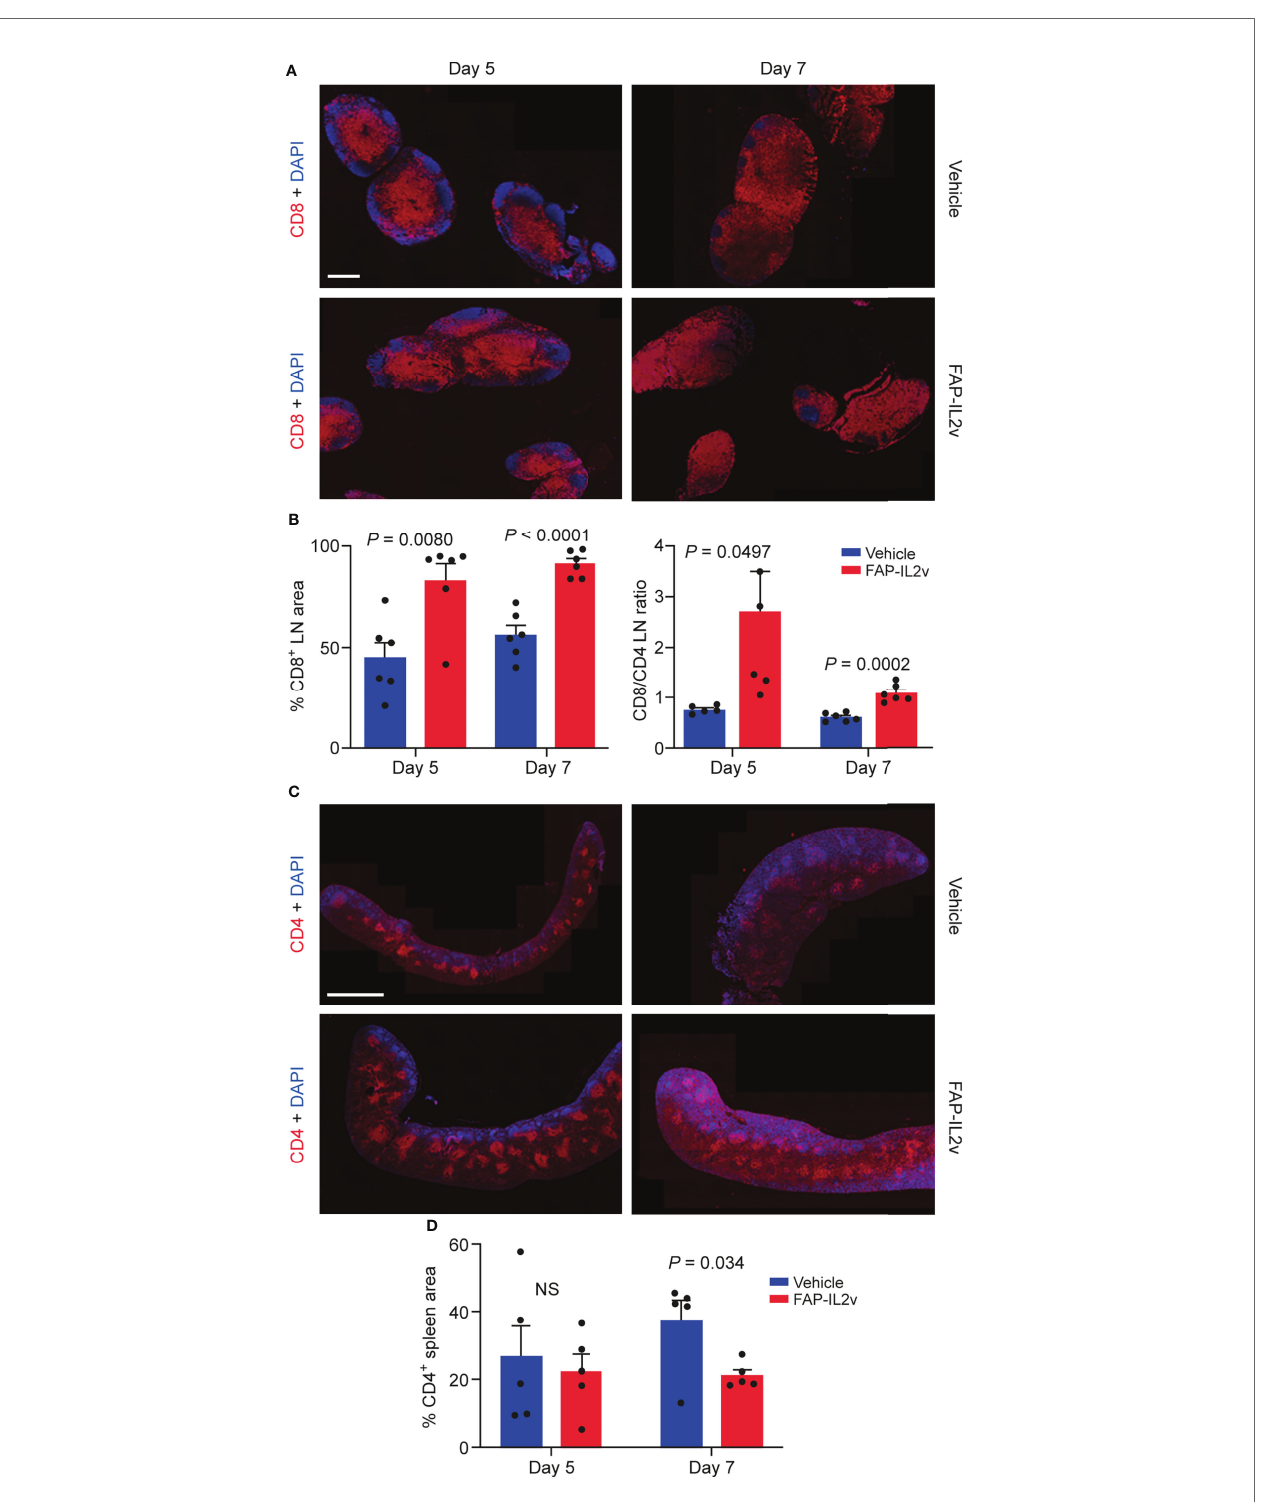
FIGURE 5 | Treatment of mice with an IL-2 variant fused to fi broblast activation protein (FAP-IL2v) induces alterations in immune cell populations. (A) Representative immuno fl uorescence staining of CD8 + T cells in lymph node (LN) sections from vehicle-treated and FAP-IL2v-treated mice. The scale bar is 800 µm. (B) The area of the LN stained positive for CD8 + T cells (as assessed by quantitative analysis of immuno fl uorescence staining) and the CD8 + /CD4 + ratio in the LN ( n = 5-6/group). (C) Representative immuno fl uorescence staining of CD4 + T cells in spleen sections from FAP-IL2v-treated and vehicle-treated mice. The scale bar is 2 mm. (D) Quantitative analysis of immuno fl uorescence staining indicates the area of the spleen in fi ltrated by CD4 + T cells ( n = 5/group). NS, not signi fi